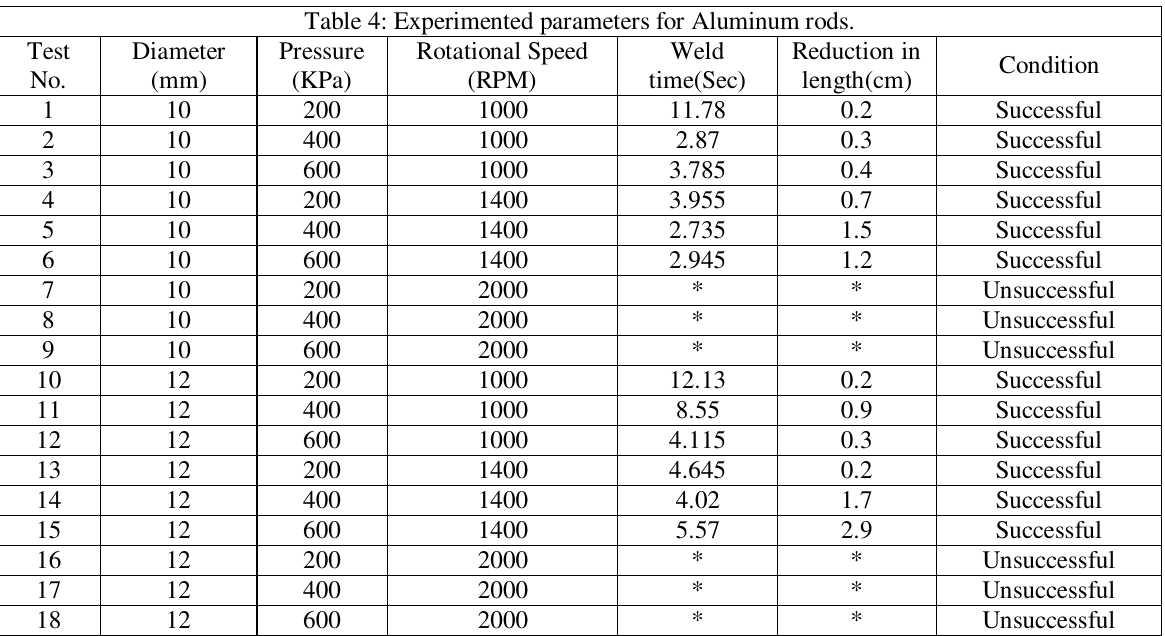
Table 4: Experimented parameters for Aluminum